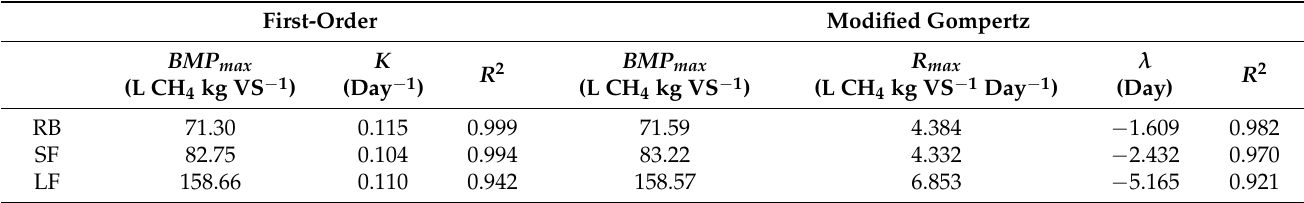
Table 5. Results of kinetics study (first-order and modified